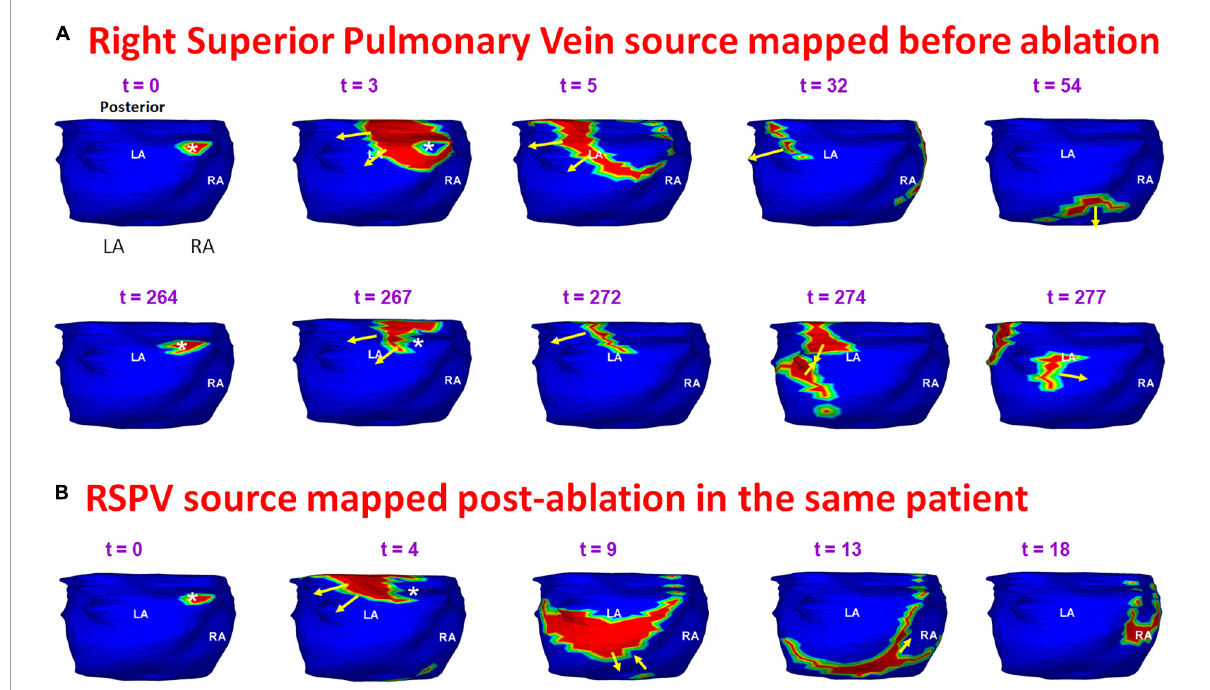
FIGURE11 Persistence of pre-ablation RSPV source during recurrent AF. Panel (A) shows pre-ablation AF driver from the right superior pulmonary vein (white asterisk) mapped twice ( t = 0, t = 264 ms) within the same mapping interval. This source was repeatedly mapped in this patient pre-ablation. The patient recurred the day after his ablation. Panel (B) shows activation maps reconstructed during recurrent AF. The source originates from the same location as pre-ablation ECGI. RSPV – right superior pulmonary vein. Supplementary Video 7 shows the activation during pre-ablation and recurrent